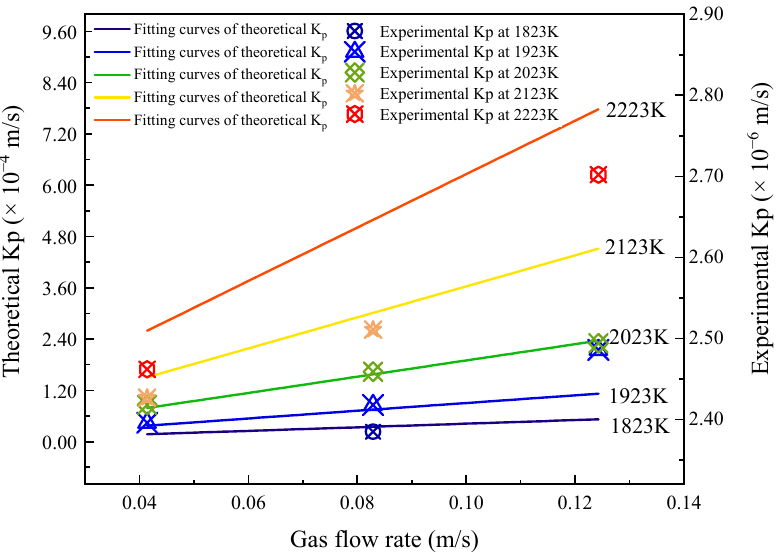
Figure 7. Effect of gas flow rate on mass transfer coefficient.